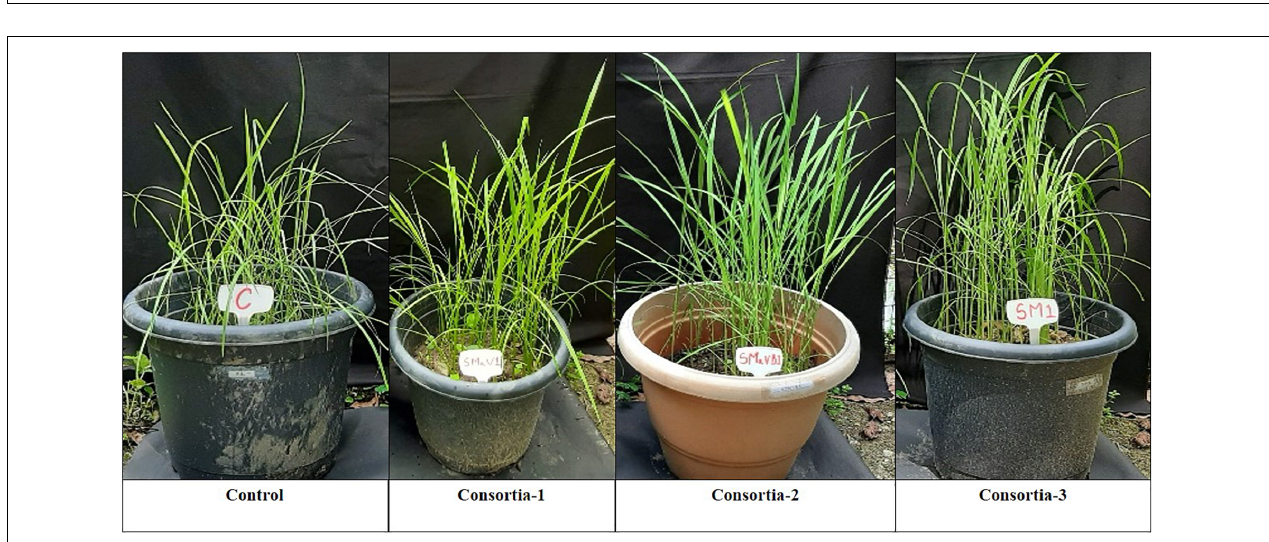
FIGURE 3 | Evaluation of three native consortia (Consortia-1, 2, and 3) on rice plants. Values are means ± SE.